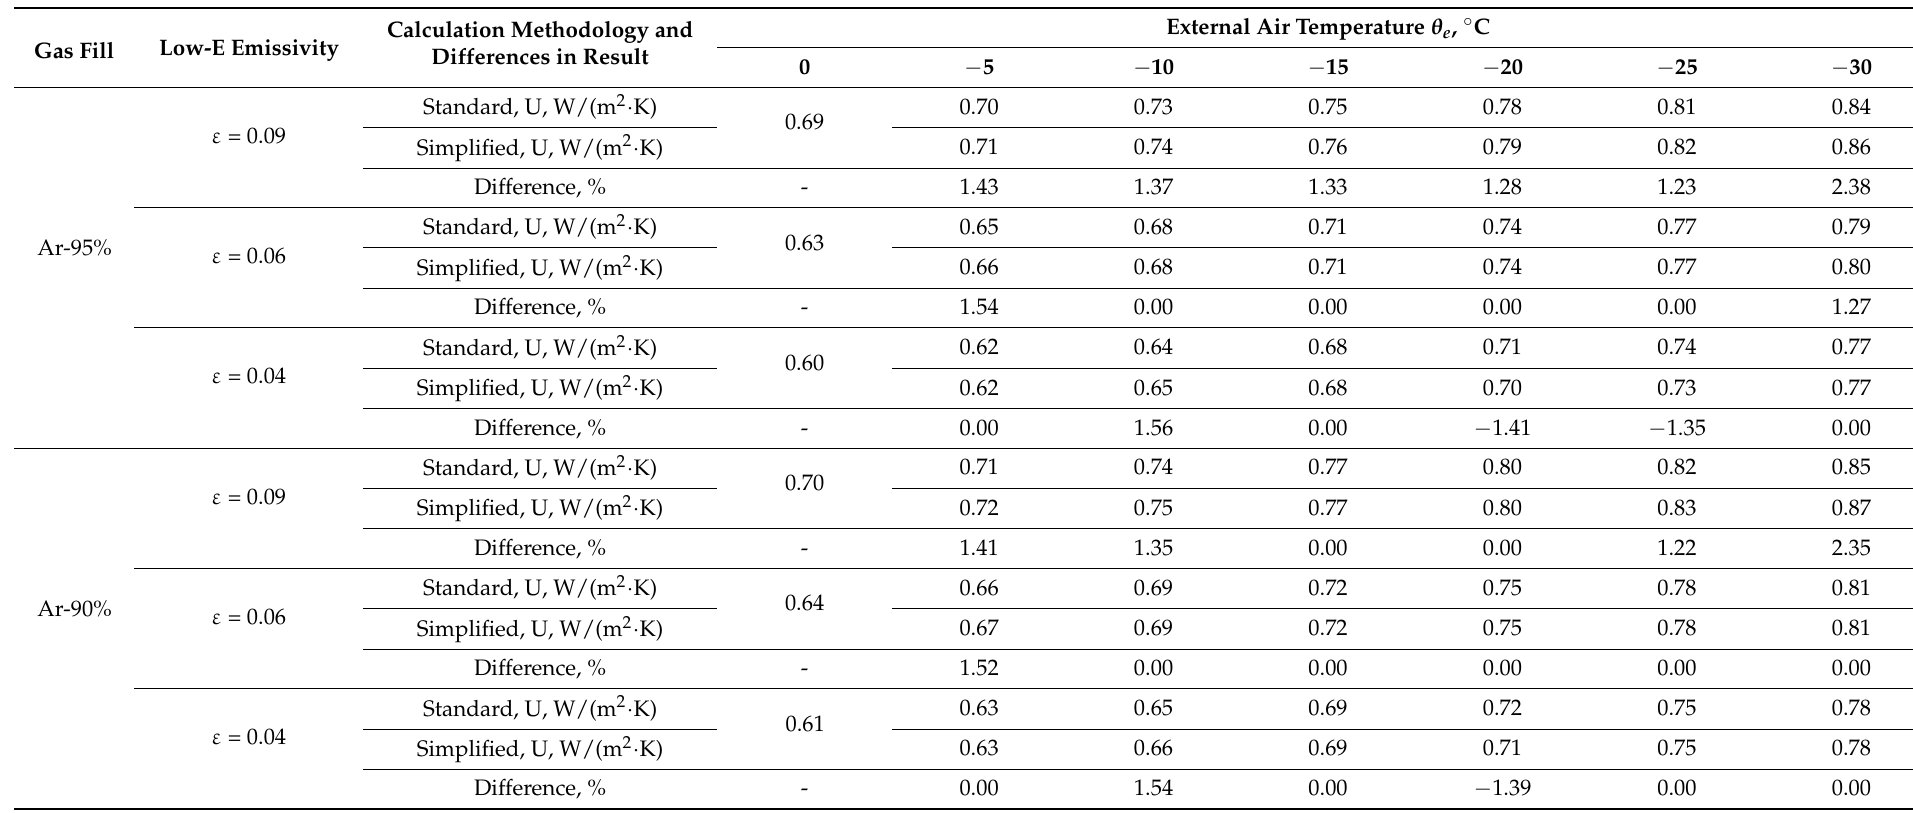
Table 9. The comparison of U-values of triple-glazed 4e-16Ar-4-16Ar-4e IGU calculated according to the standard methodology and simplified